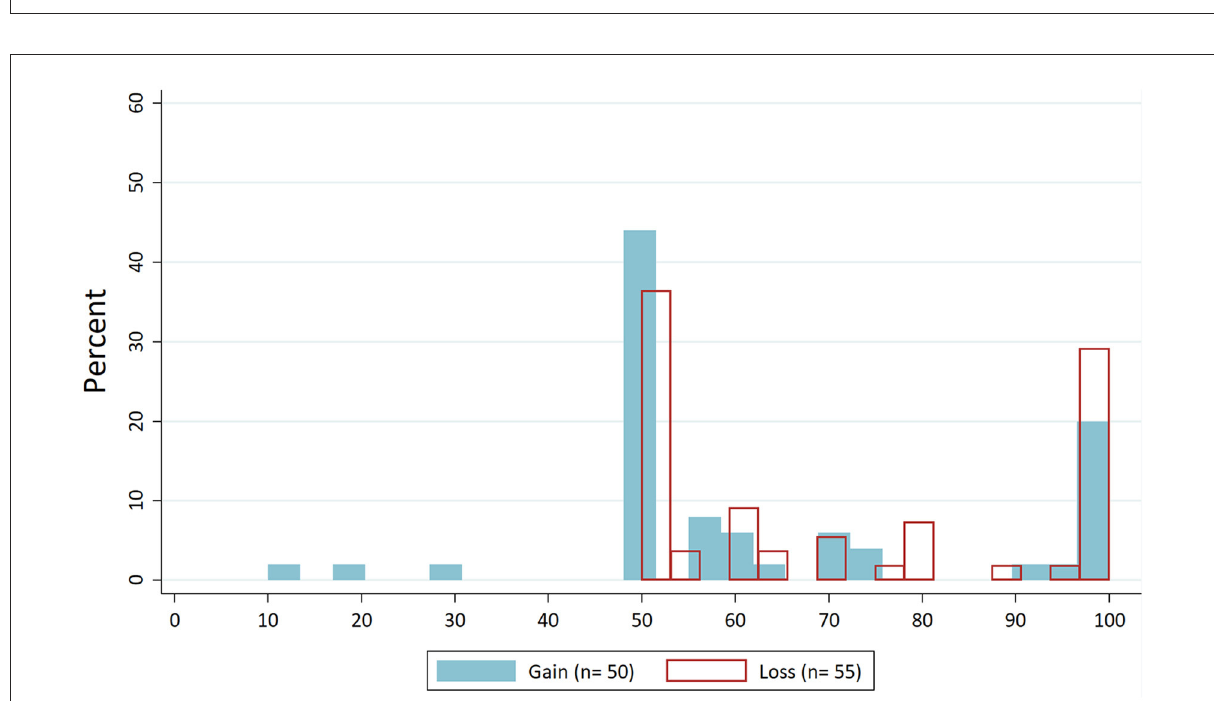
FIGURE1 Means of dictators’ demands per treatment.